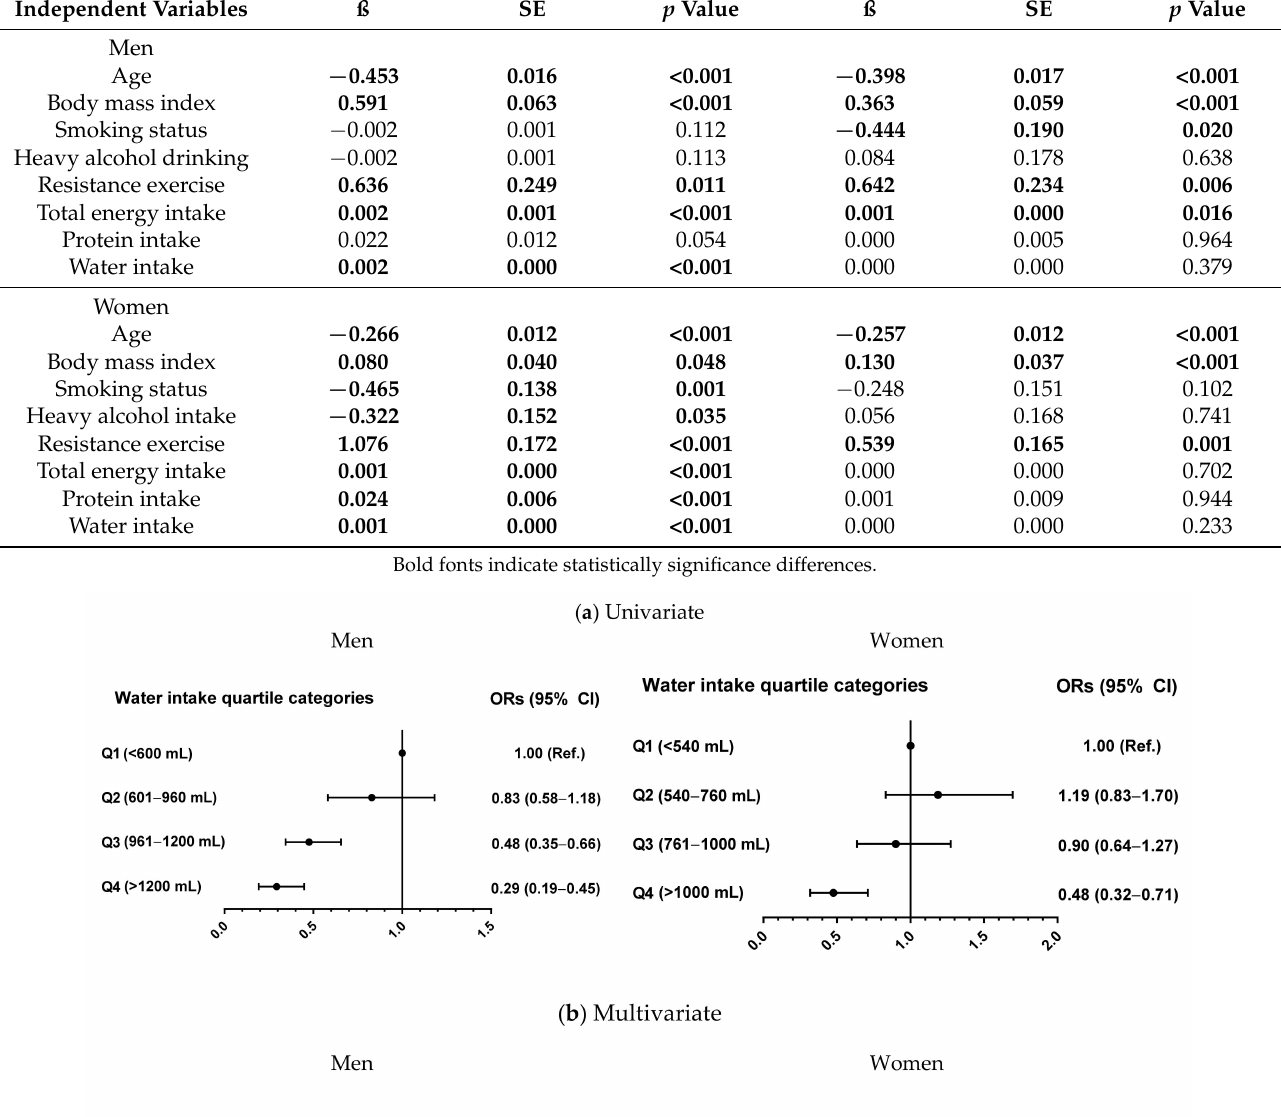
Table 2. Covariates independently associated with hand grip strength by linear regression analyses. Unadjusted for Covariates